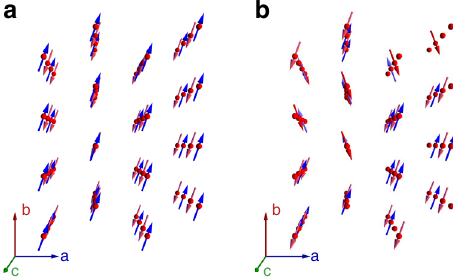
Fig. 8 Con fi guration of H 2 O dipole moments from Monte Carlo simulations. We show the con fi guration of the molecular dipoles of water in cordierite crystalline matrix at zero temperature with two fi lling factors of Fig. 7 Dielectric susceptibility and antiferroelectric order parameter. water molecules. Red and blue colors correspond to directions along (blue) Temperature dependences of the dielectric susceptibility (red) and and against (red) the b -axis. a 100% fi lling factor. Dipoles are oriented antiferroelectric order parameter (blue) of nanocon fi ned H 2 O molecules ferroelectrically in the ab -planes and antiferroelectrically along the c -axis. along the a -axis. The dielectric susceptibility is de fi ned through the (cid:8) (cid:9)P b 75% fi lling factor corresponding to the studied hydrous cordierite ¼ 1 = V p a V is the crystal volume, the sum is polarization P i ; j ; k ijk , where a taken over all lattice points ( i, j, k ) corresponding to the lattice axes ( a, b, c ), p a p along the a -axis at a position ( i, j, ijk is the component of the water dipole k ), the electric fi eld component E degrees of freedom than the water dipoles, r ij is the distance between two dipoles p i a along the a -axis enters the corresponding ¼ P = ε E ε expression for dielectric susceptibility via χ and p j , and n ij is the unit vector between them. The presented results were obtained 0 is the a 0 a , aa for a sample with 16 lattice sites along each axis (a total of 4096 sites) and a 75% permittivity of vacuum. The antiferroelectric order parameter is calculated (cid:8) (cid:9)P dipole fi lling factor with N = 3072 dipoles in total (25% of sites were free of dipoles, (cid:2) 1 ð Þ k p a N is the number of dipoles in the as η a AF ¼ 1 = N p a j j i ; j ; k ijk , where we called them defects). Free boundary conditions were applied. These results were crystal. The dependences were obtained by Monte Carlo simulations for the well reproduced in simulations with a fi nite interaction radius cut-off r c (with up to electric-dipolar system of water molecules in hydrous cordierite crystal the 4th next-to-nearest neighbors in the ab -plane, which corresponds to 640 lattice sites in the interaction sphere) with periodic boundary conditions. However, in the with N = 3072 and fi lling factor 75%. latter case, the dipoles con fi guration at the lowest temperature usually consists of domains of radius r c even in the absence of defects and converges slowly to the ground state. Therefore, we avoided this method in order to see the dipoles con- fi gurations in the presence of defects more reliably. The dielectric susceptibility removed from the subsequent analysis. To fi nd out whether van der Waals (vdW) forces play any signi fi cant role in interaction between the water molecules and the along each axis α was calculated from fl uctuations of the average dipole p α ¼ P N ions of nanocage, we performed test calculations using the non-local dispersion N (cid:2) 1 corrected vdWDF2 functional 72 (Supplementary Fig. 6, Supplementary Note 1). dipoles in a simulation, p 0 = 1.85 D is the water molecular dipole, υ 0 is the volume per dipole, k B is the Boltzmann constant. For each temperature, the number of Monte Carlo steps per spin was 3500 (the fi rst 500 were attributed to thermali- Monte Carlo simulations . Metropolis algorithm was used to simulate at different zation). The results were averaged over 30 samples with different randomly gen- temperatures the behavior of the dipole system governed by the dipole – dipole (cid:4) (cid:5) (cid:4) (cid:5)(cid:4) (cid:5) P erated defect con fi gurations. From DFT-MD analysis it was deduced that at low r (cid:2) 3 p p (cid:2) 3 p n n p interaction Hamiltonian H ¼ 8 π ε r ε 0 ð Þ (cid:2) 1 . Here, ij ij i j i j ij ij temperatures the dipoles tend to orient at certain angle relative to the b -axis. An ε = 5 is the relative dielectric permittivity due to other ε angle of 20° was taken for all simulations. 0 is the dielectric constant, r